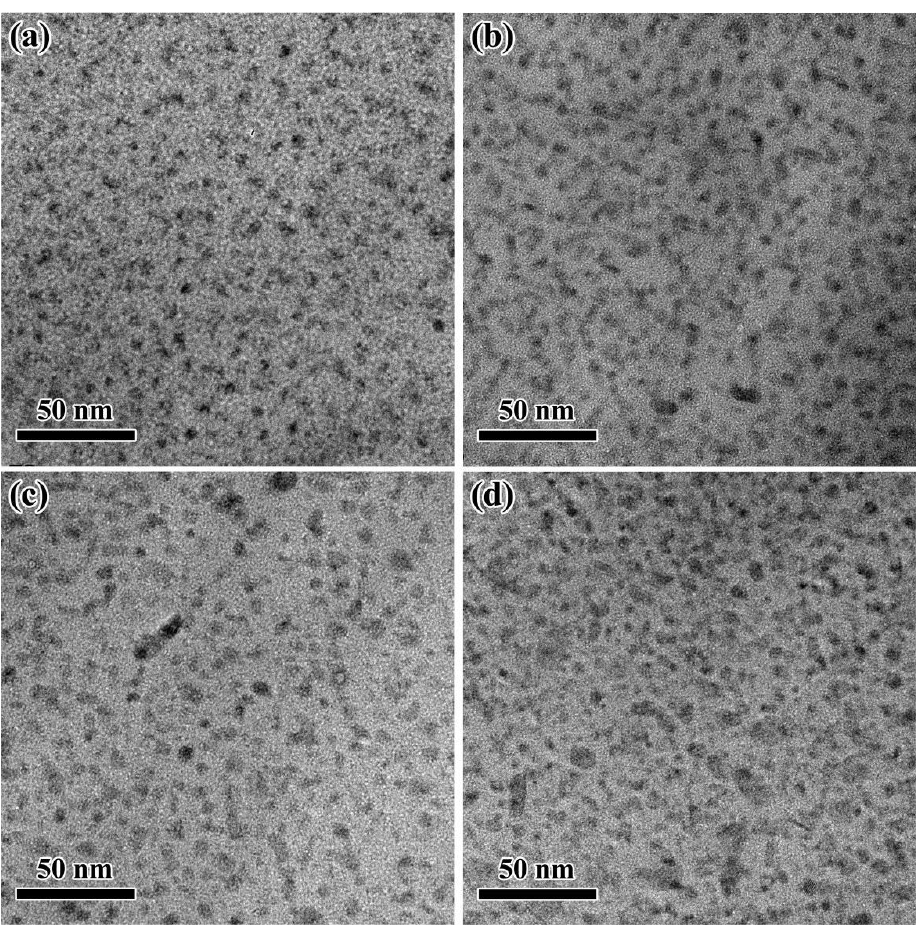
Figure 3. Lower magnification TEM images of precipitates after aging at 120 °C for 28 h with different strains: ( a ) 0; ( b ) 0.10; ( c ) 0.15; ( d ) 0.20.